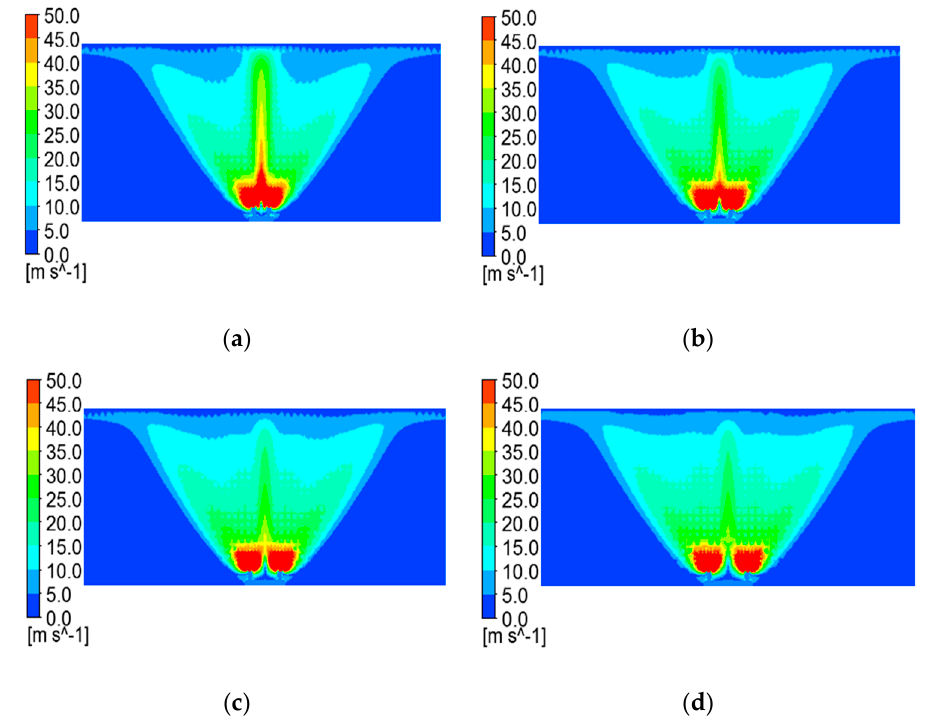
Figure 5. Velocity contours at section z = 0 for different L when θ = 10 ° : ( a ) L = 20 mm; ( b ) L = 30 mm; ( c ) L = 40 mm; ( d ) L = 50 mm.